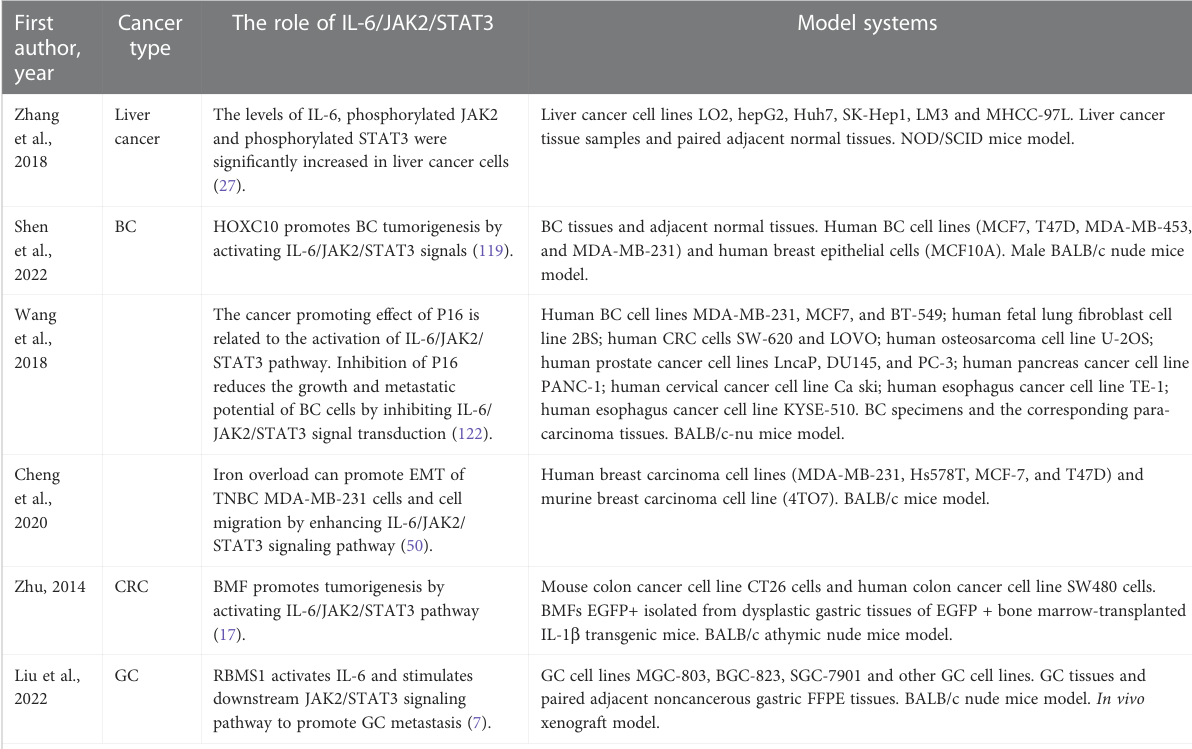
Liver The levels of IL-6, phosphorylated JAK2 cancer and phosphorylated STAT3 were signi fi cantly increased in liver cancer cells (27).